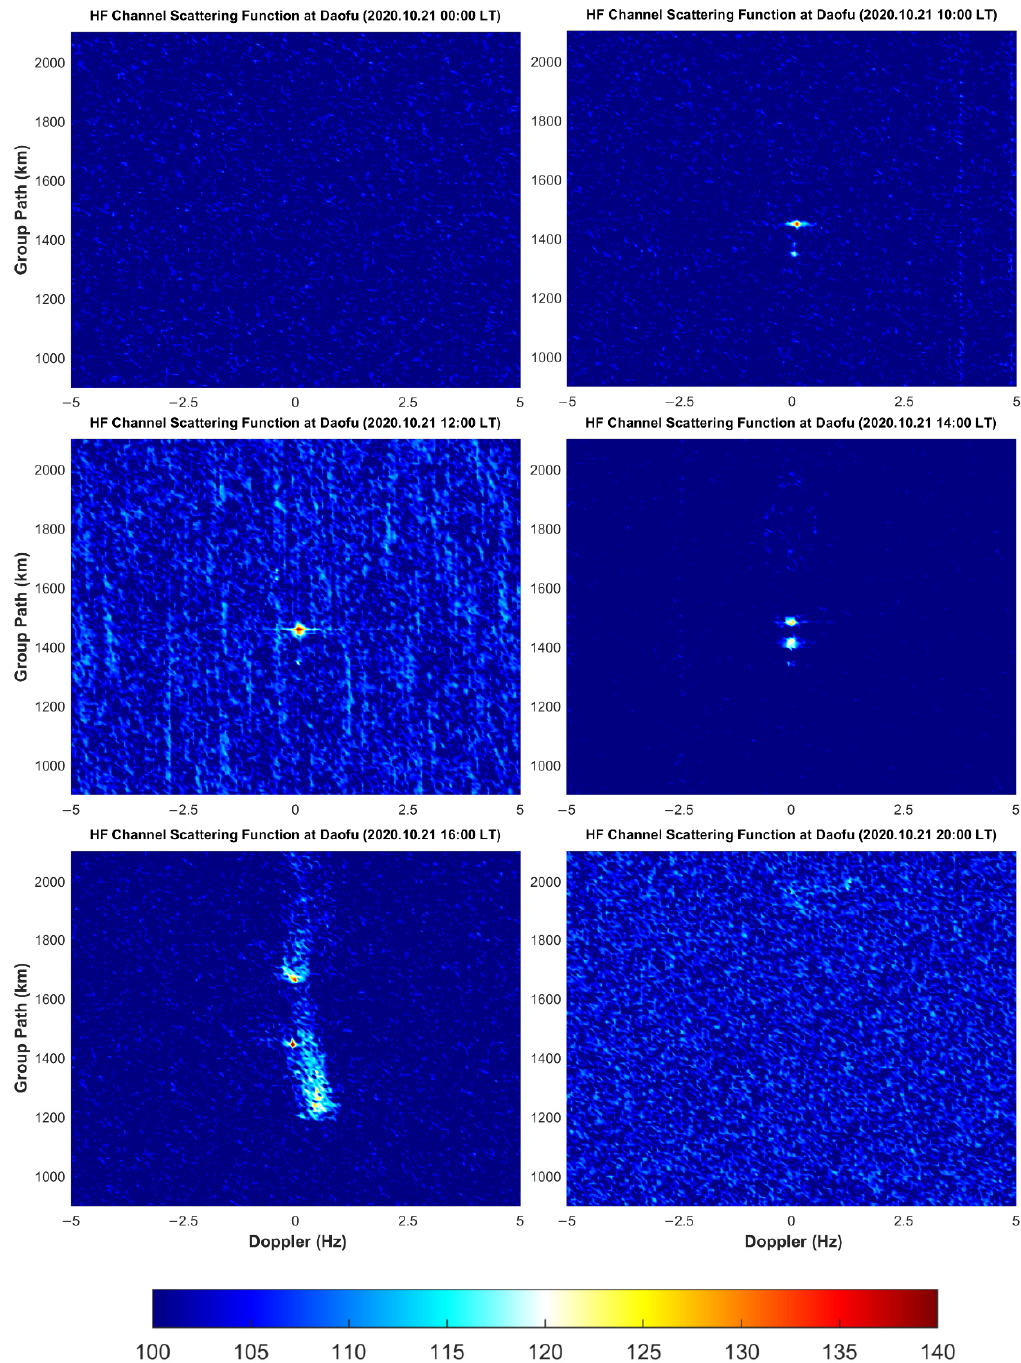
Figure 5. 21 October 2020, data processing results of Daofu station. Refer to the captions in Figure 2 for the receiving time and other descriptions of each panel. Because the ground distance between Wuhan and Daofu is greater, the SNR of this figure is lower and the quality of the HF channel is also worse compared to Figure 2. The group paths of the HF signals reflected by the E layer are about 1350 km, and the group paths of the HF signals reflected by the F layer are about 1400 km.